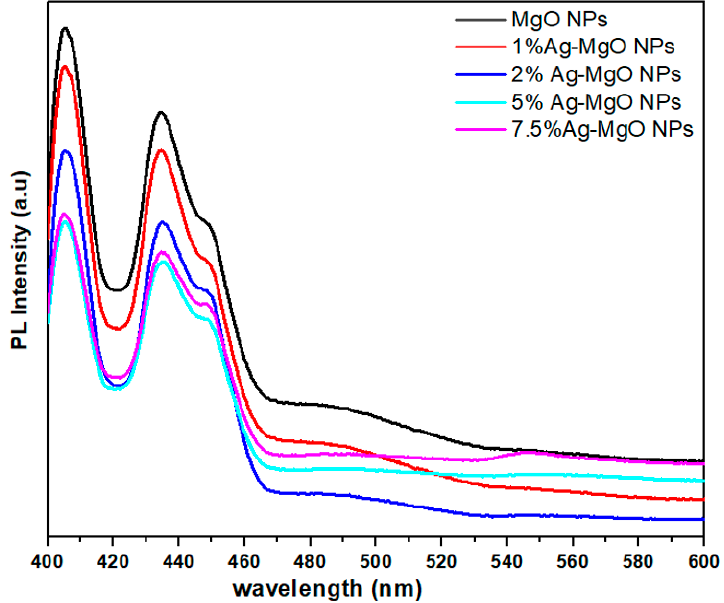
Figure 8. Photoluminescence spectra of pure, 1%Ag ‐ MgO, 2% Ag ‐ MgO, 5% Ag ‐ MgO, and 7.5%Ag ‐ MgO